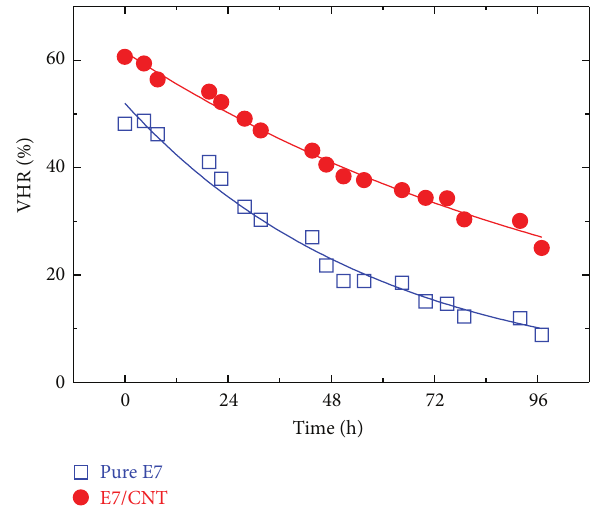
Figure 5: Time-evolved VHR curves in a period of 96h.